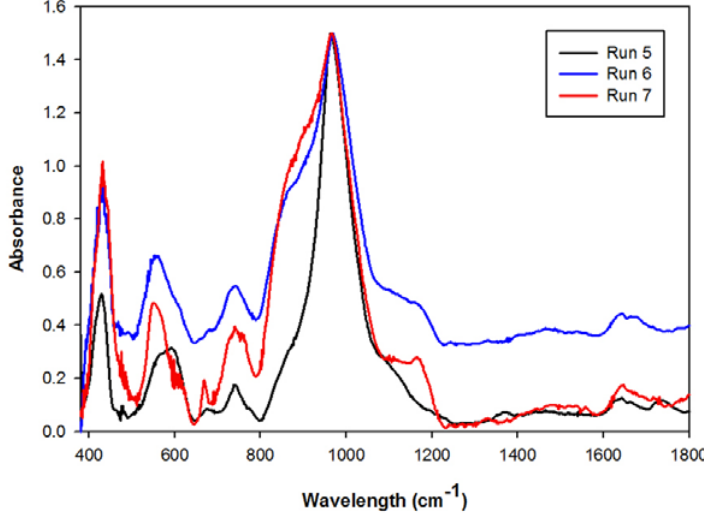
Figure 7. Infrared spectra of products obtained after recycling the supernatant waste as a source of NaOH.